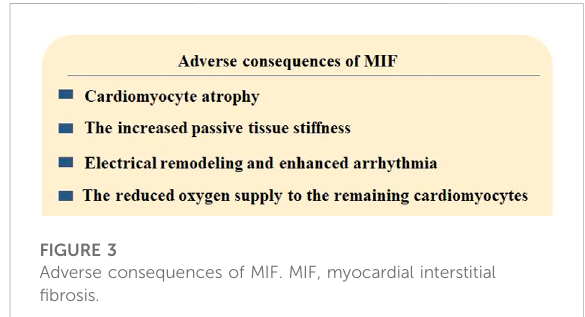
FIGURE 3 Adverse consequences of MIF. MIF, myocardial interstitial fi